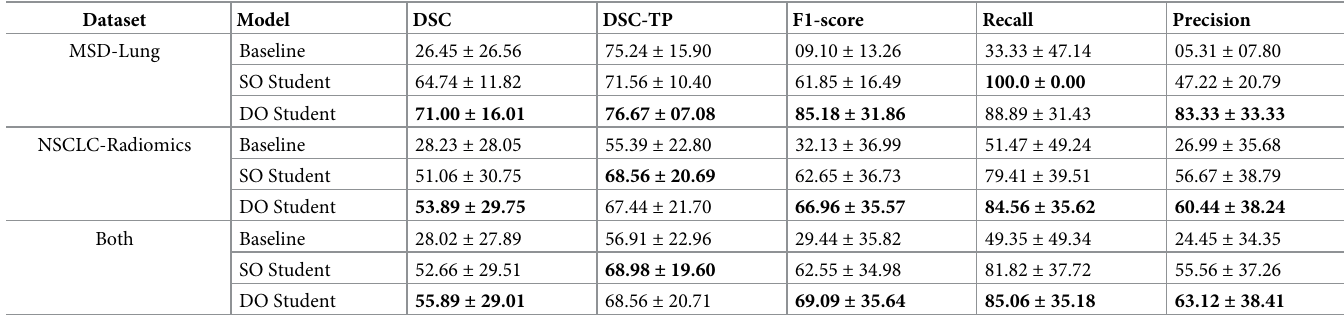
Table 5. Scarcely trained student